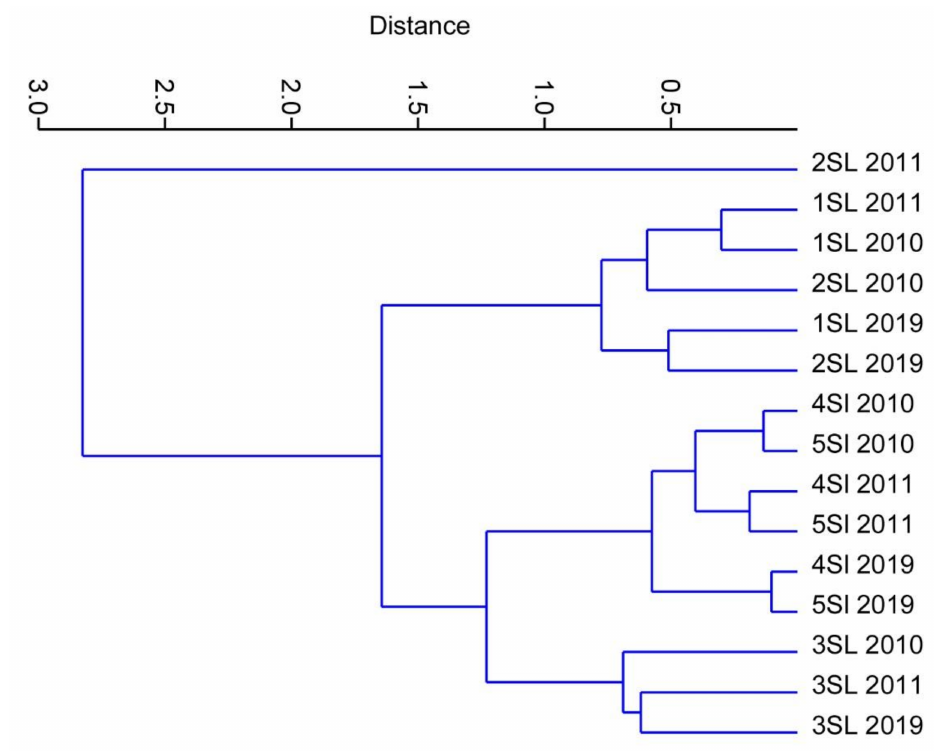
Figure 6. Dendrogram derived from the hierarchical cluster analysis (HCA) of risk elements in the water samples, in relation to time and space, of the Slovinsk ý creek